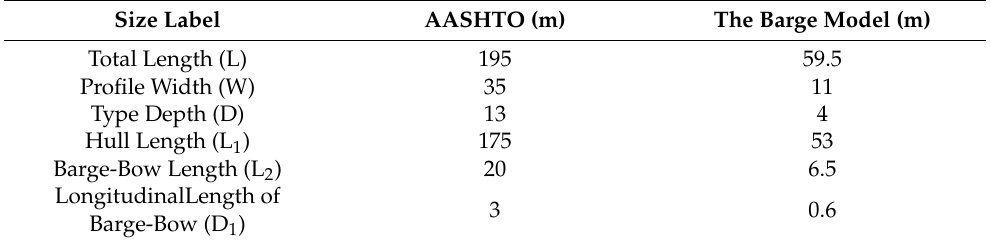
Table 4. The size of JH barge.